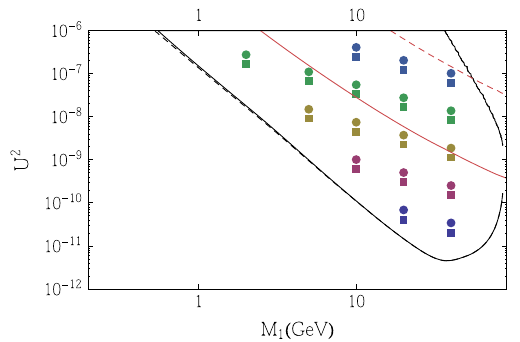
Fig. 2 Lines corresponding to two expected events for scenarios II ( solid ) and IV ( dashed ) in [20]. The indicated points correspond to the CP conserving case and γ = 2 , 3 , 4 , 5 , 6 in ascending order for IH ( circles ) and NH ( squares ). The red lines in the top right corner correspond to one-loop corrections to neutrino masses being of the same order as the atmospheric splitting for (cid:9) M / M 1 = 1 ( solid ) and (cid:9) M / M = 0 . 01 ( dashed 1